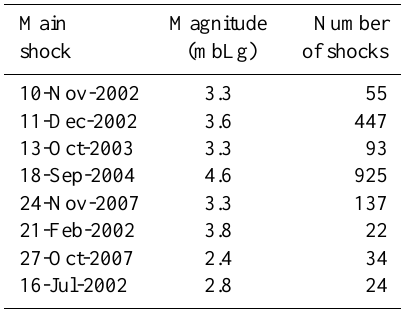
Table 2. Main clusters in the catalogue. D 2 is the correlation di-